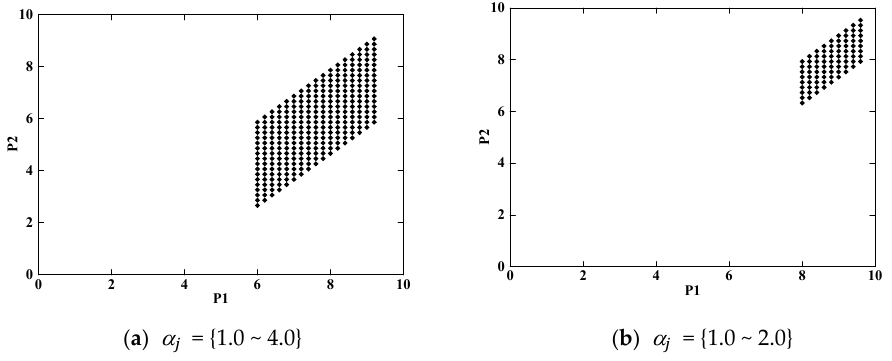
Figure 9. The impact of utility functions on pruning efficiency